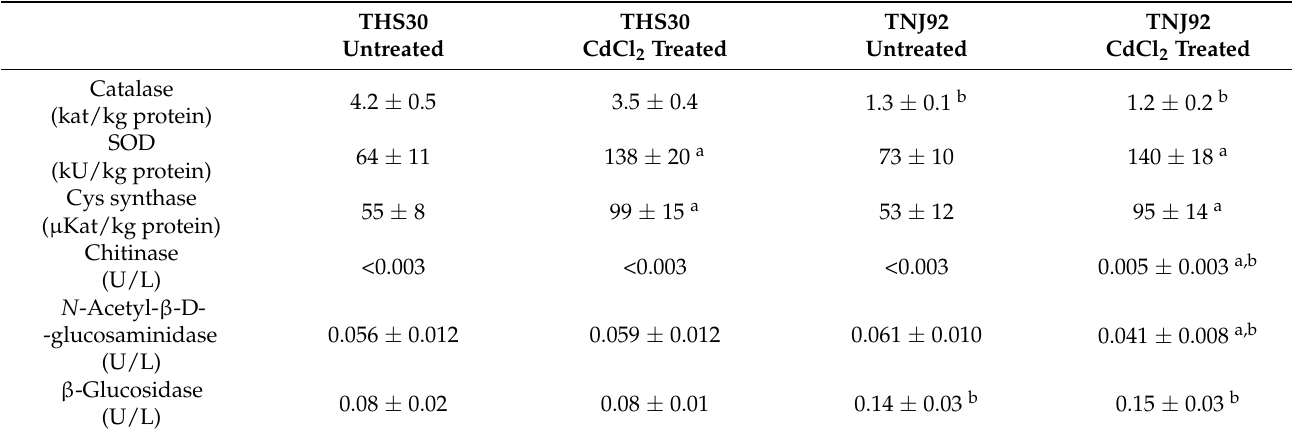
Table 1. Specific activities of selected enzymes in CdCl 2 -treated and untreated cultures of A. nidulans THS30 (reference) and TNJ92 ( ∆ atfA )